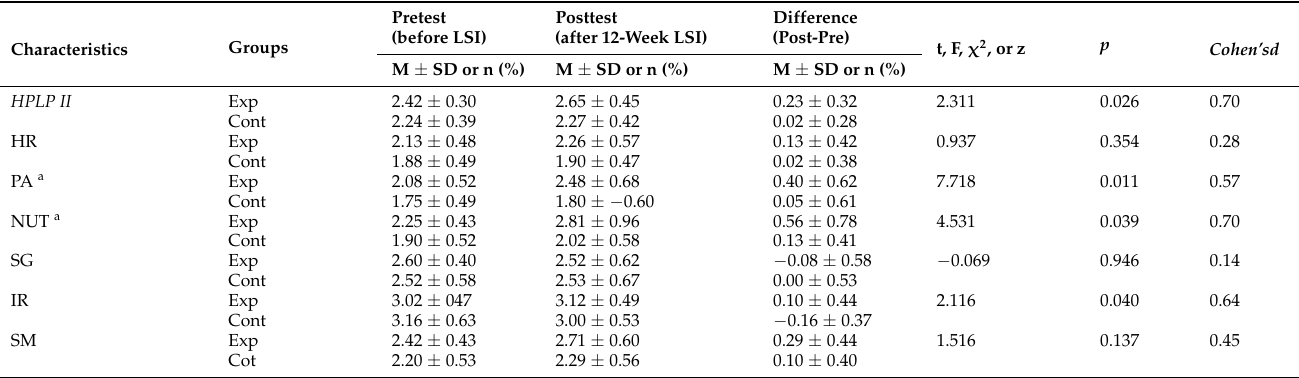
Table 3. Effects of the lifestyle intervention on health-promoting lifestyle, psychological distress, reproductive health, and body composition in the experimental and control groups (N =